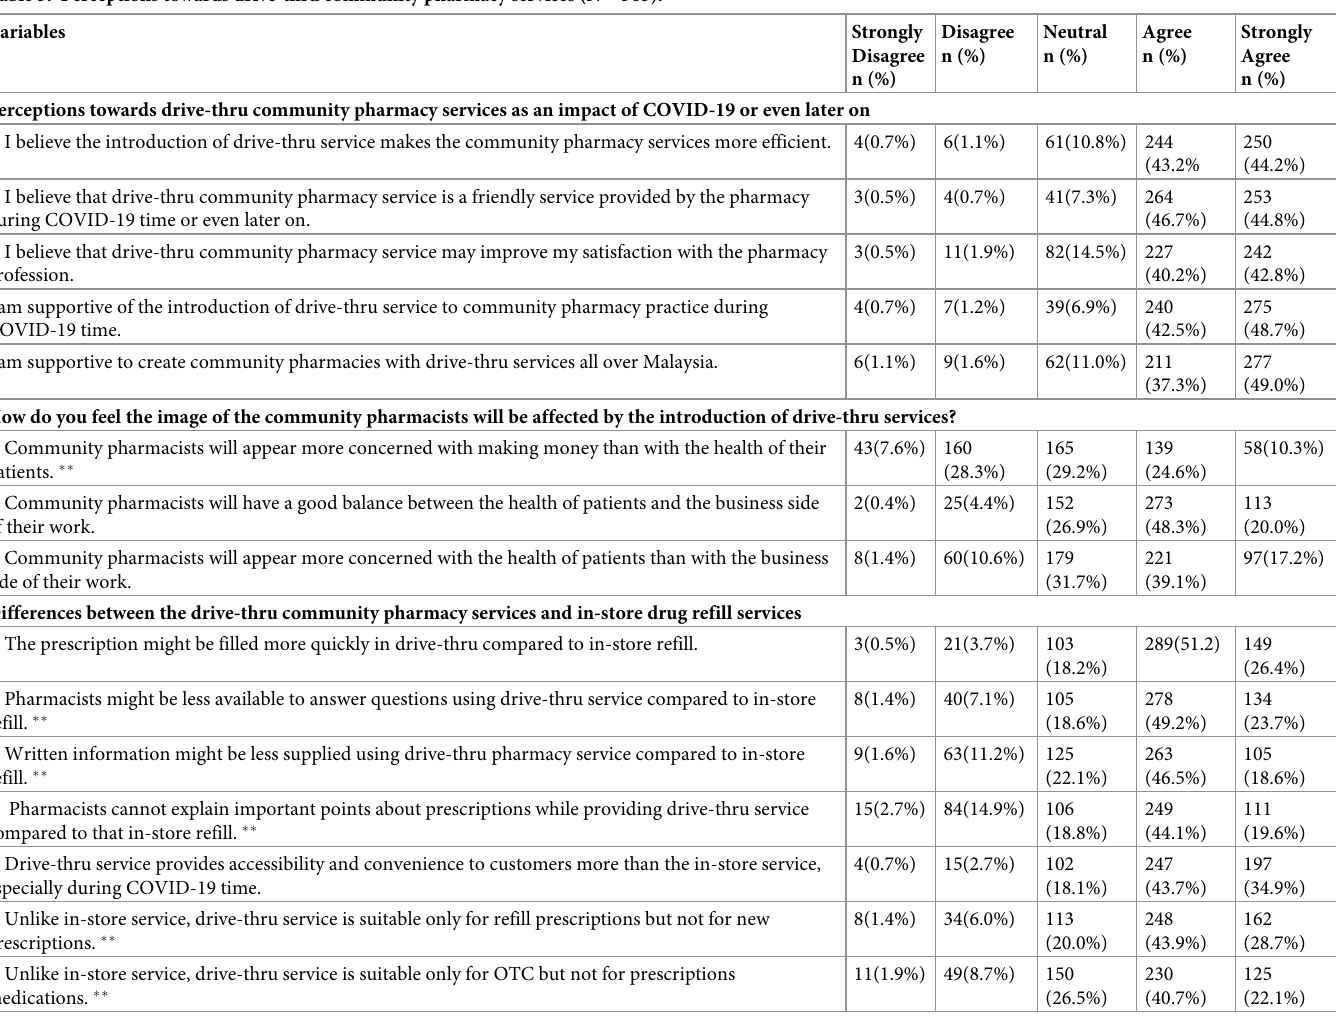
Table 3. Perceptions towards drive-thru community pharmacy services (N =